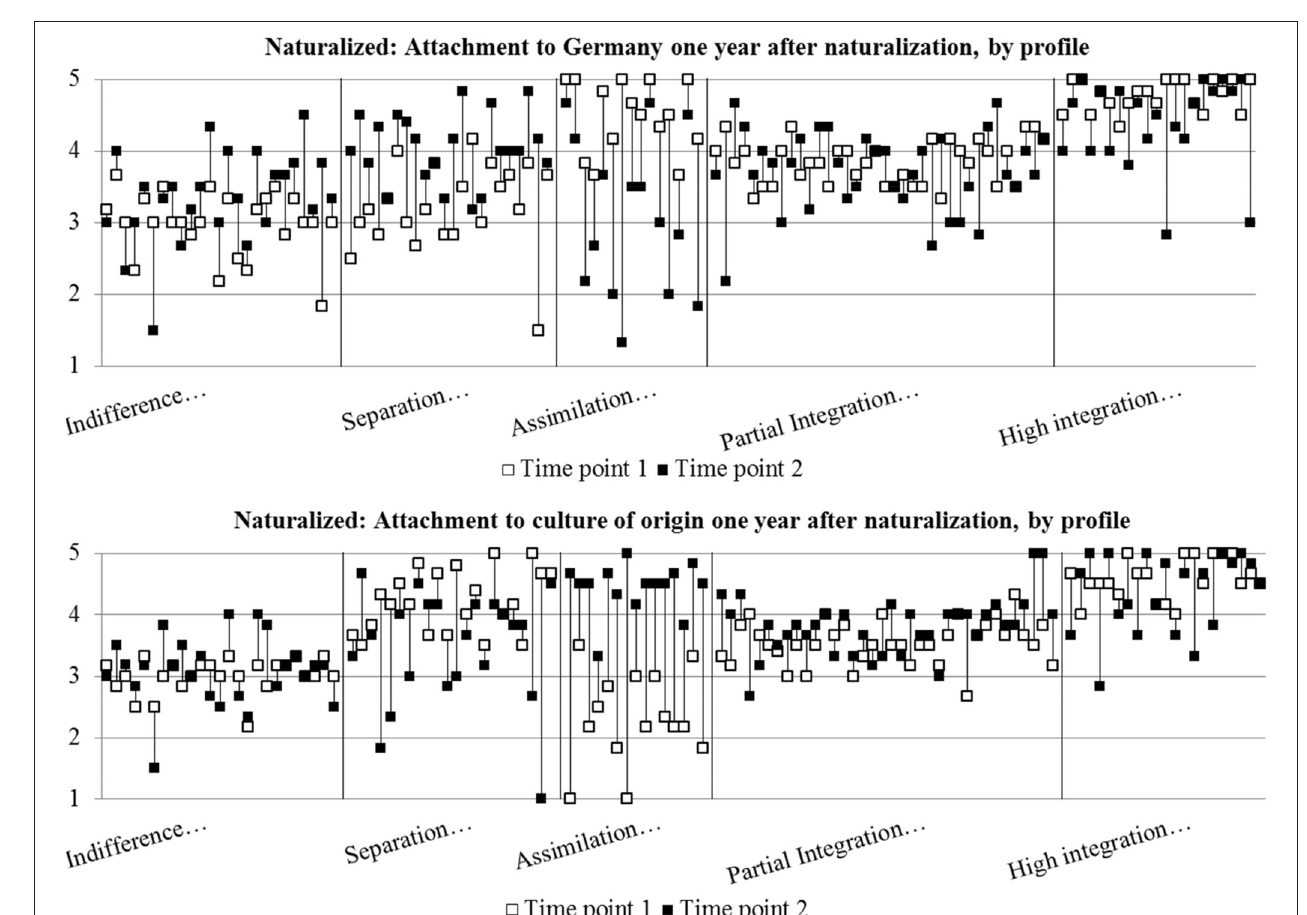
FIGURE 4 | Acculturation profiles of immigrants in Germany 1 year after naturalization.